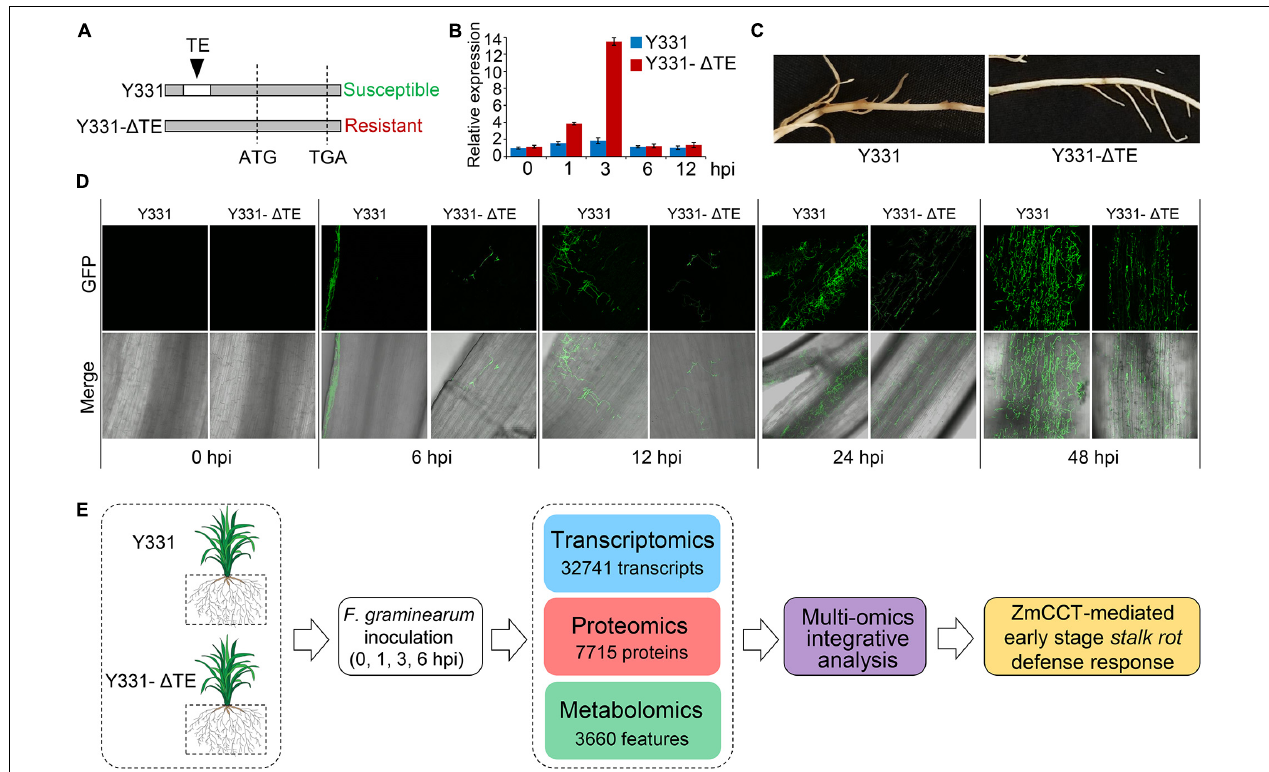
FIGURE 1 | Framework of integrative multi-omic analysis of early-stage defense response to GSR in maize. (A) Sketch maps of NILs Y331- (cid:49) TE1 and Y331 at the ZmCCT locus. (B) Expression profiles of ZmCCT in Y331- (cid:49) TE1 and Y331 seedling roots inoculated with Fusarium graminearum at different time points. Data were normalized to Y331 at 0 h post-inoculation (hpi). For each sample, the ZmGAPDH gene was used as the internal control. Error bars present the ± s.d. of three biological replicates. (C) Symptoms of the F. graminearum -inoculated maize seedling roots at 72 hpi. (D) Growth and distribution of GFP-tagged F. graminearum in diseased root tissues of Y331- (cid:49) TE1 and Y331 at different time points. (E) Strategy for multiple omics analysis of ZmCCT-mediated defense response in